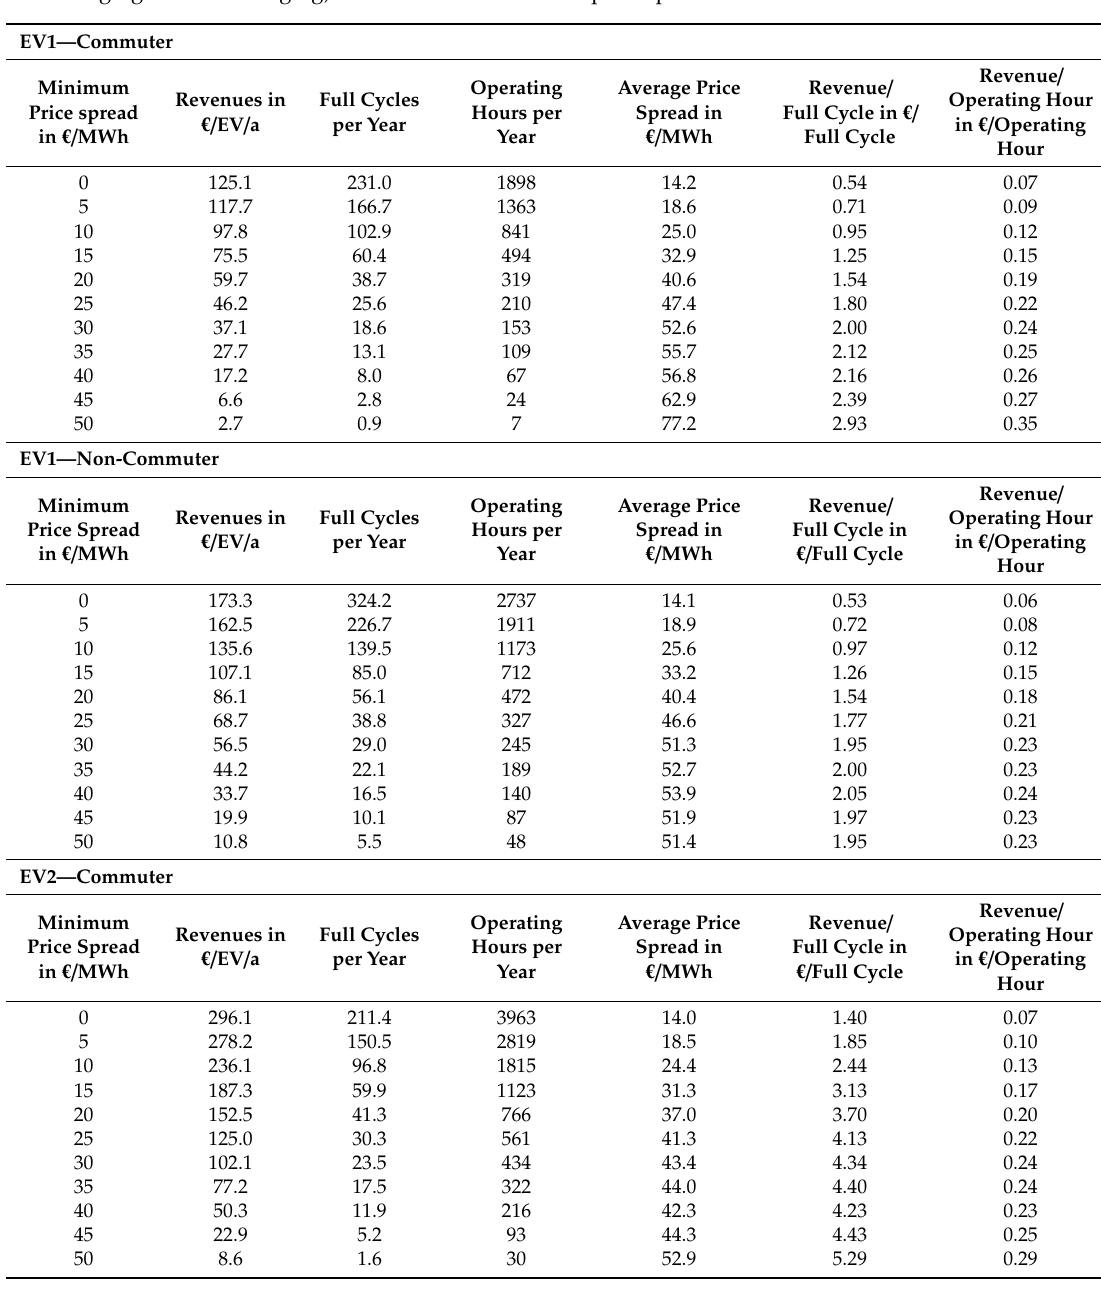
Table A2. Revenues, full cycles and operating hours for all EV scenarios (di ff erence of bidirectional charging to smart charging) with restricted minimum price